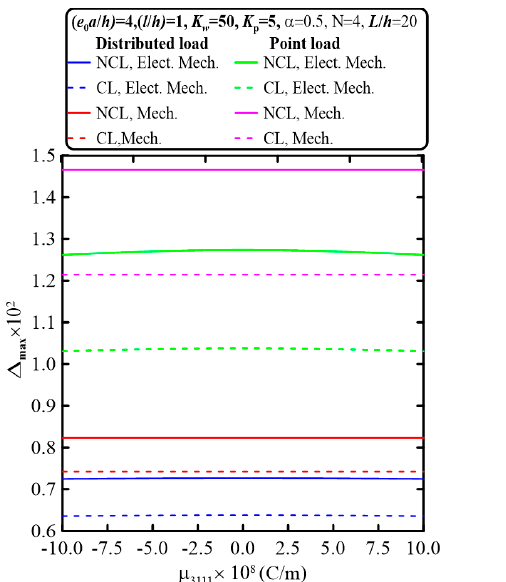
Table 8. The relative percentage difference in the transverse deflection due to increasing the piezo- electric coefficient e 311 and the electric-field–strain-gradient coupling coefficient ( μ 3111 ) for electrome- chanical and mechanical nonclassical and classical behaviors for different values of filling ratio un- der point and uniformly distributed loads at beam aspect ratio L / h = 20, 50, abs( e 311 ) = − (0 to 15) C/m 2 , abs ( μ 3111 ) = (0 to 10) × 10 − 8 C/m, a 33 = 7.124 × 10 − 9 C/m 2 K, K w = 50, K p = 5, α = 0.5, N = 4, 1 .